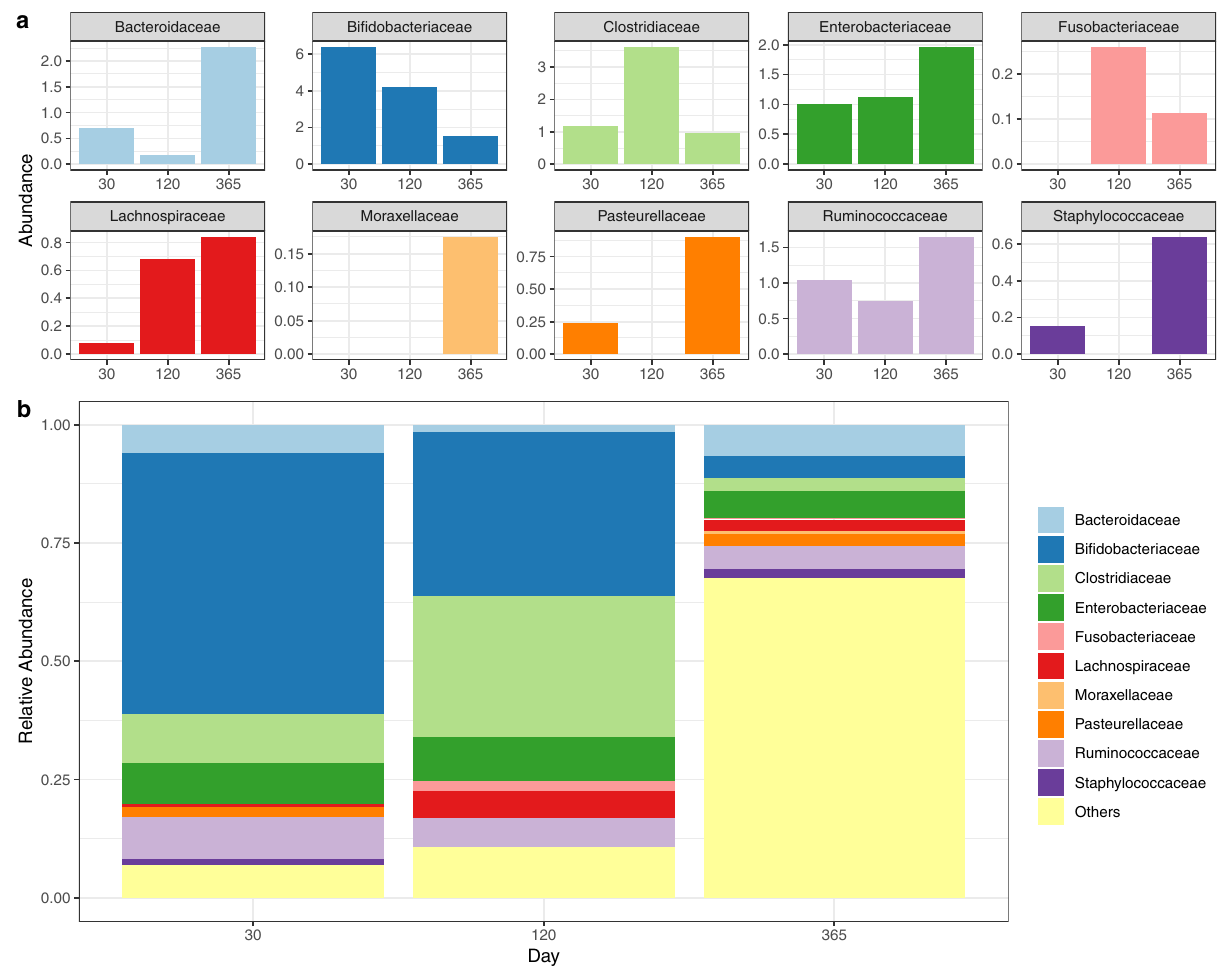
Fig. 6 | Temporal patterns of bias-corrected abundance and relative abun- dances for Norwegian infant gut microbiome data among families. The x-axis represents days (30, 120, and 365 days) and the y-axis denotes either the bias- corrected ( a ) abundances or b relative abundances. The top ten most abundant